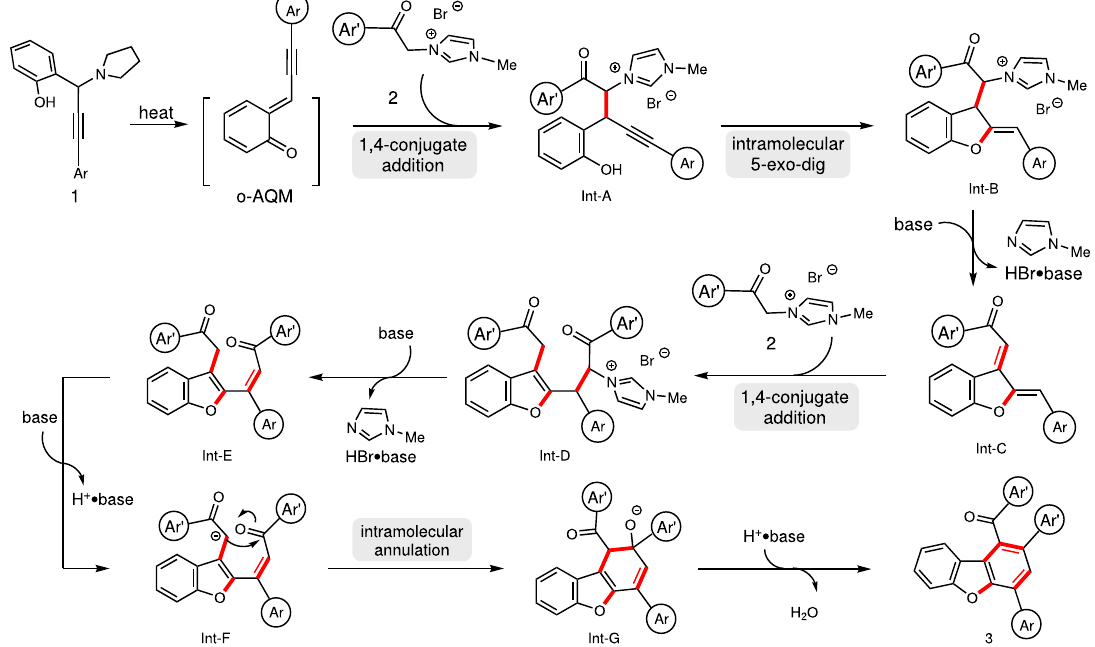
Fig. 5 A proposed mechanism. A hypothetical reaction mechanism for the formation of multiple arene-substituted dibenzofurans is presented.